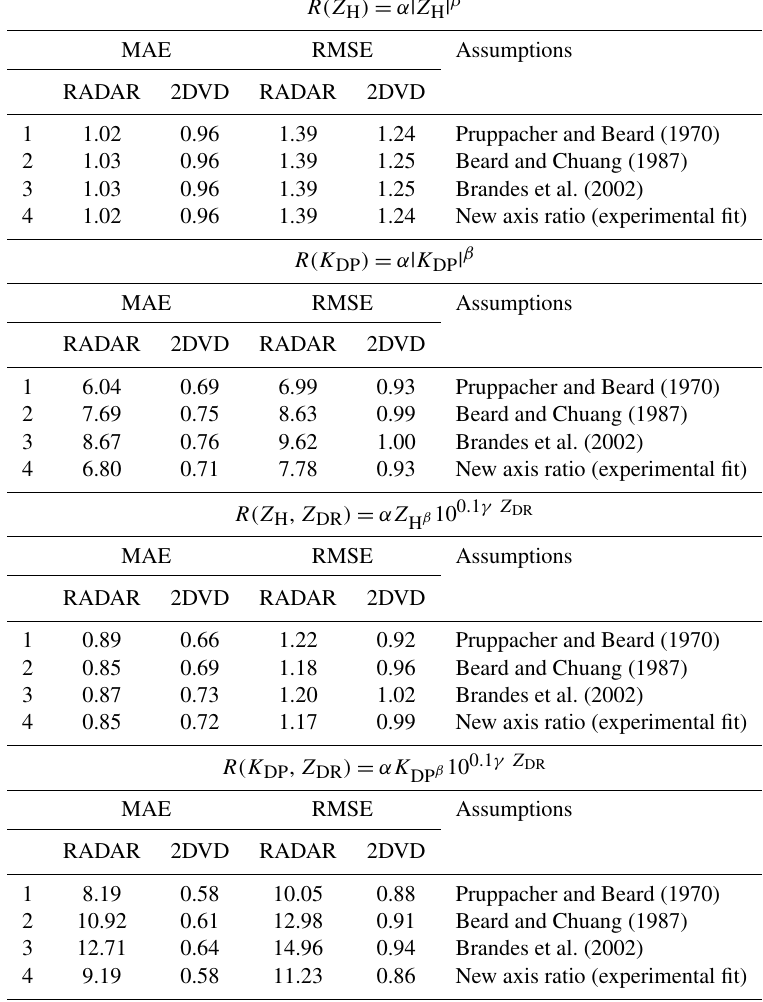
Table 4. Mean absolute error (MAE) and root-mean-square error (RMSE) of the radar estimates of hourly rain rates for the different radar rainfall algorithms listed in Table